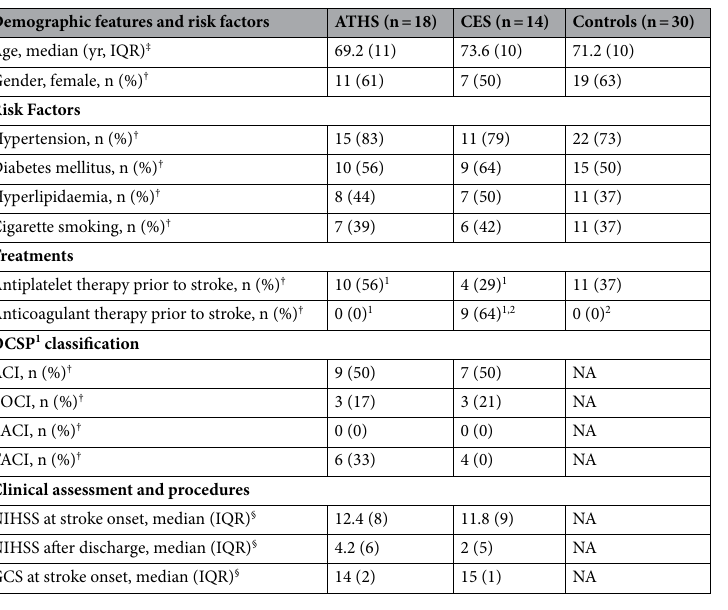
Table 1. Demographic features, risk factors, stroke classification, clinical assessment, and procedures of ATHS, CES and control group. Categorical variables are expressed as number (n) and percentage (%). Numerical variables are expressed as median ± IQR. OSCP The Oxfordshire Community Stroke Project, PACI partial anterior cerebral infarction, POCI posterior cerebral infarction, LACI lacunar cerebral infarction, TACI total anterior cerebral infarction, NIHSS National Institute of Health Stroke Scale, GCS Glasgow Coma Scale.